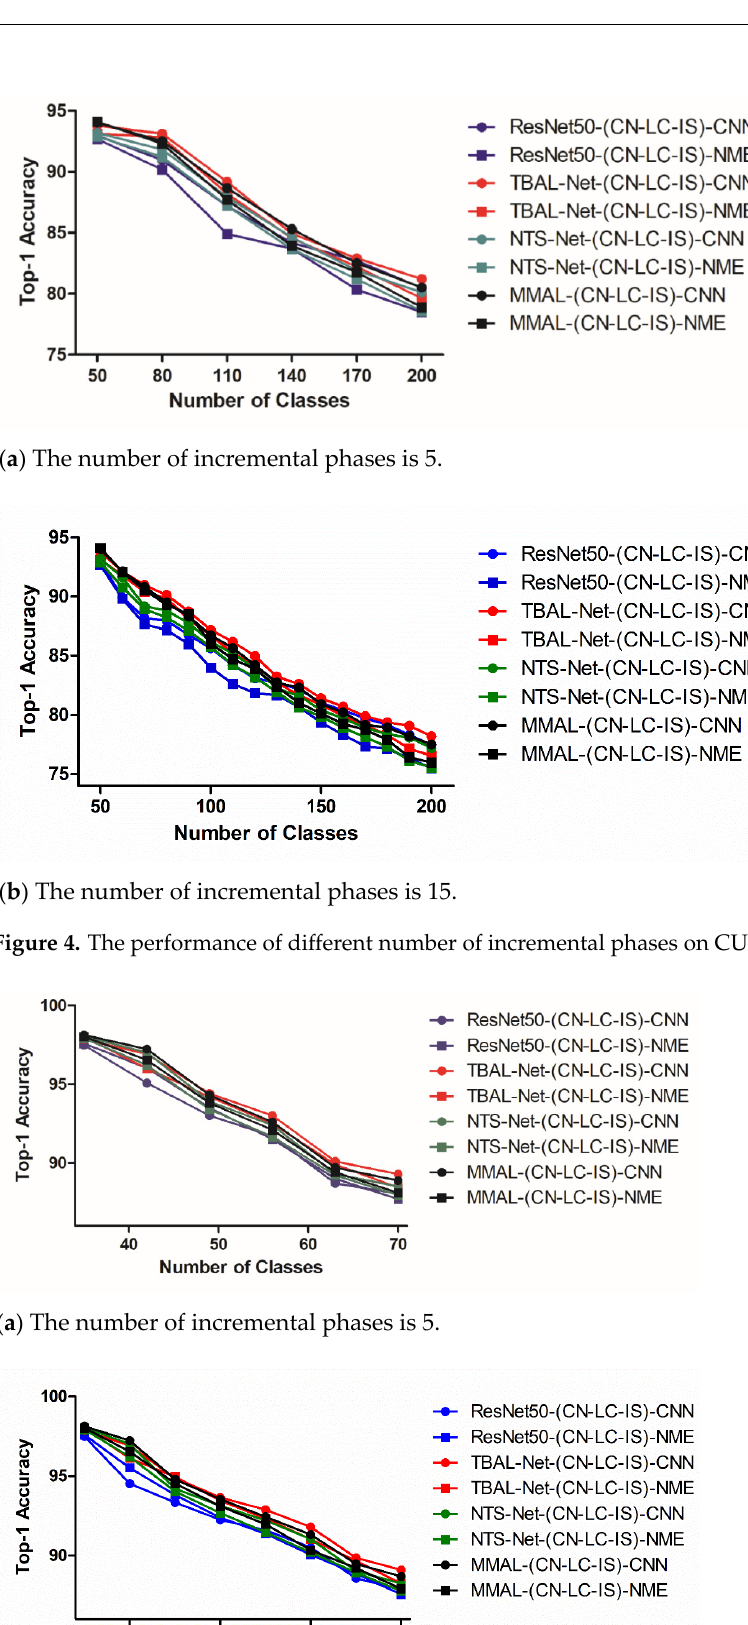
76.563 Table 3. Performance of TBAL-Net with/without attention modules on FGVC-Aircraft (Top-1 Accuracy). Method 88.233 Table 4. Performance of TBAL-Net with/without attention modules on Stanford-Car (Top-1 Accuracy). Method